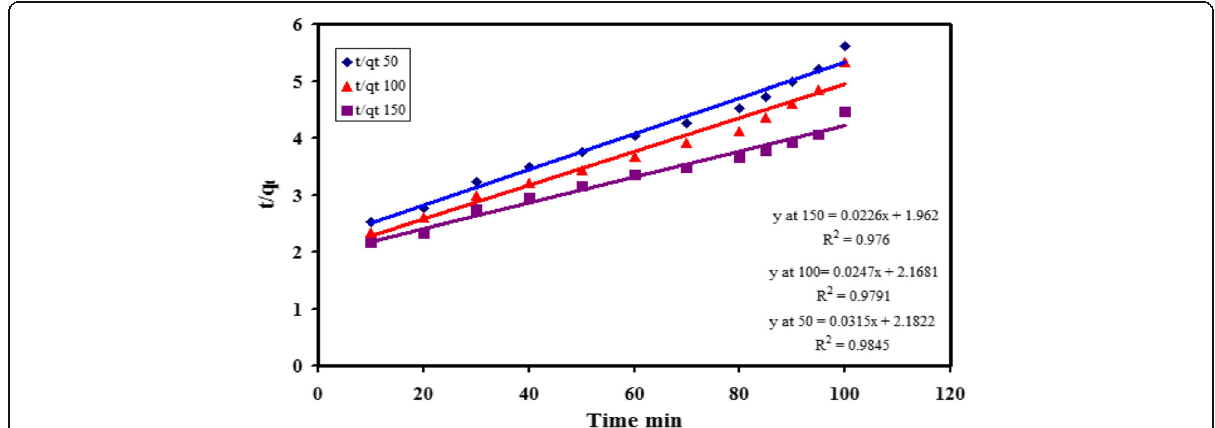
Fig. 10 Pseudo-second-order model plot at different concentration of adsorption AO67 onto RPSF [pH = 2.5, temperature 25 °C, and adsorbent dose 0.2 g]